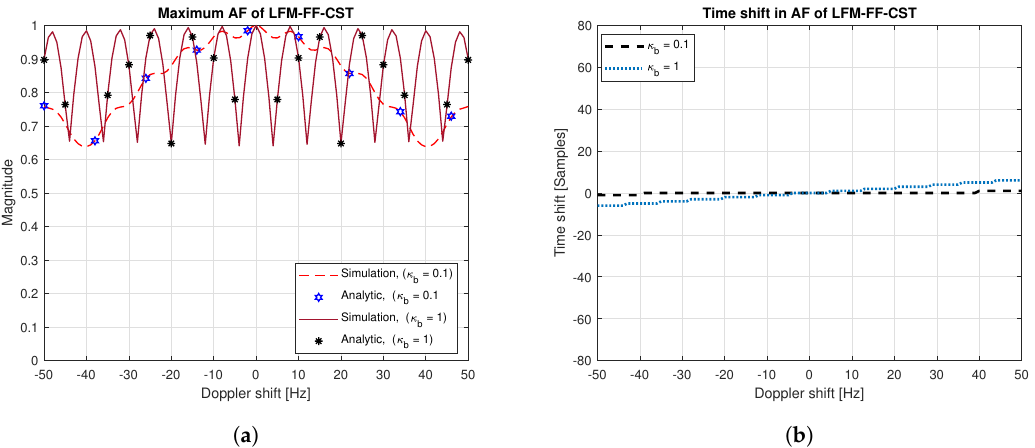
Figure 5. Time-domain waveform and auto-correlation of LFM-FF signal. ( a ) Time-domain waveform; ( b ) Auto-correlation.